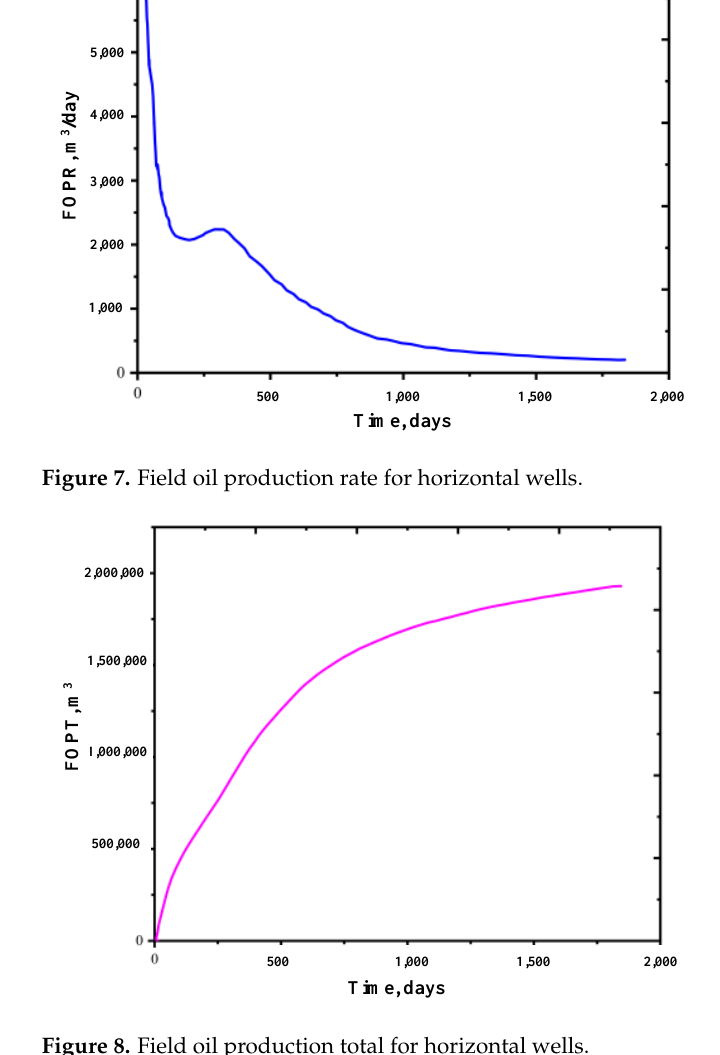
Figure 9. Field oil efficiency for horizontal wells. 3.1.2. Field Water Production The simulated field water production rate versus time is shown in Figure 10. It can be seen that water production increased with time. Water started to be produced after 180 days. Water cut is the ratio of water produced to the total fluid produced. According to conservation of mass (i.e., material balance) in oil reservoirs, the extracted volume of fluid is relatively constant throughout the well lifetime, but the water share (or water cut) in- creases with time. As oil is extracted from the reservoir, an increased water cut causes a decline in the oil production flow despite high reservoir pressure. As seen in Figure 11, the water cut increased, which indicates that the injected water broke through and then started to be produced with the oil. After 180 days, water started to be produced with the oil. After water breakthrough, there was a rapid water cut rise, and a slower water cut rise in the late period. The water cut rising curve was convex after water breakthrough. Figure 10. Field water production rate for horizontal wells.